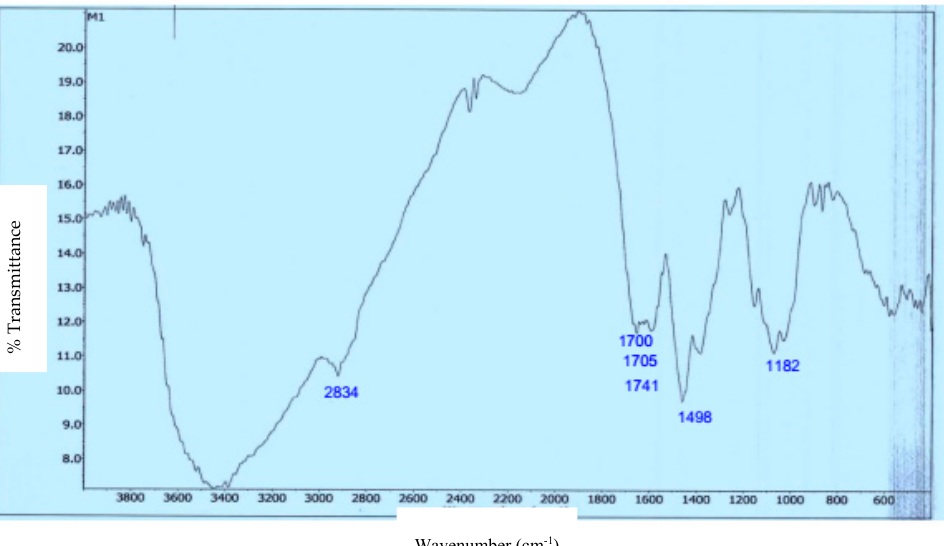
Figure 3. 13 C-NMR spectra of CS-FUAC.